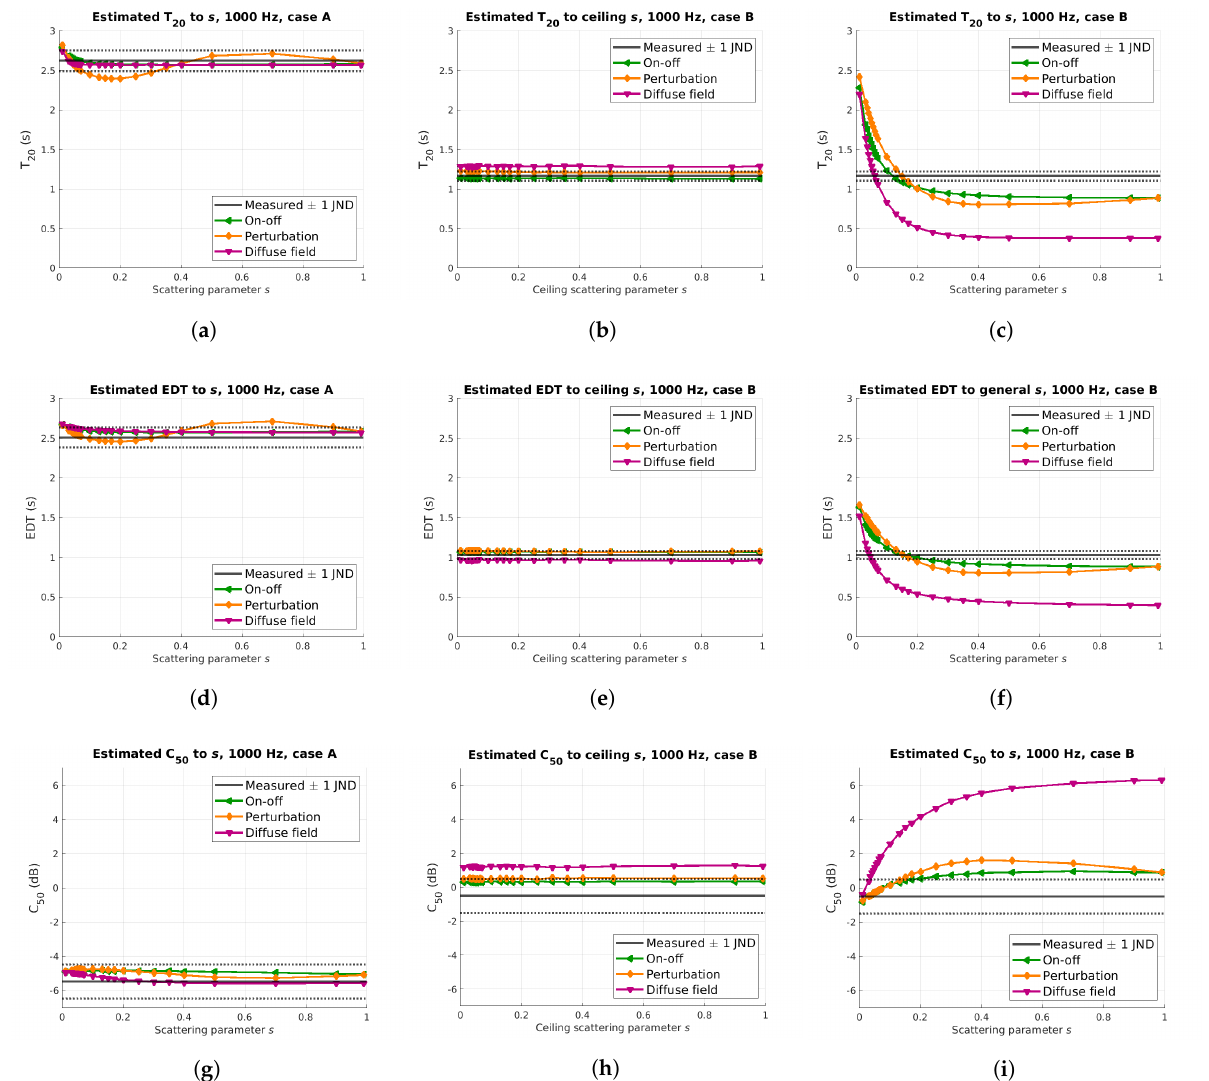
Figure 9. Simulated T 20 ( a – c ), EDT ( d – f ) and C 50 ( g – i ) as they change when the scattering parameter is modified. For the absorbing ceiling, changes to the scattering parameter does not affect the simulation results. In general, increasing the scattering parameter for the remaining surfaces leads to a decrease in reverberation (as shown in both T 20 and EDT) for the on–off and diffuse field algorithms. It is also seen that the effects of the scattering parameter are much more significant in case B, for all algorithms but for the diffuse field algorithm in